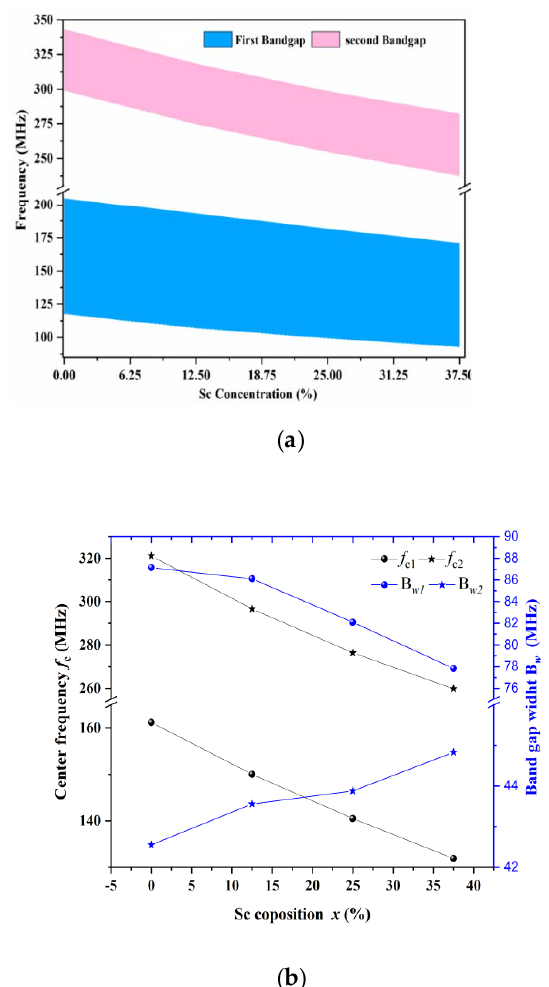
Figure 9. Evolution of ( a ) the bandgaps map, and ( b ) the center frequency f c and bandgap width B w of the first and second bandgaps with Sc concentration ( x ).